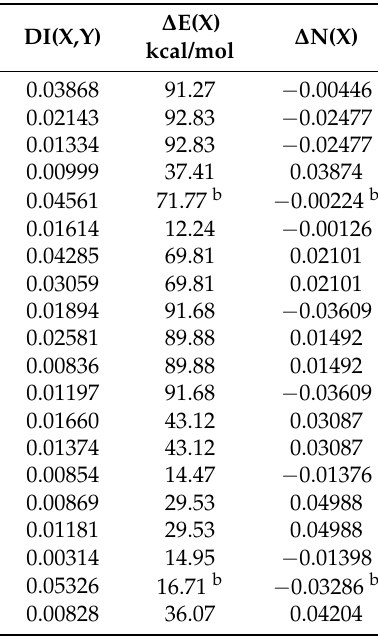
Table 1. Topological parameters of the BCP of bond in adsorption configurations of guest molecules (CO 2 , H 2 O and H 2 ) on IRMOF-C-BF 2